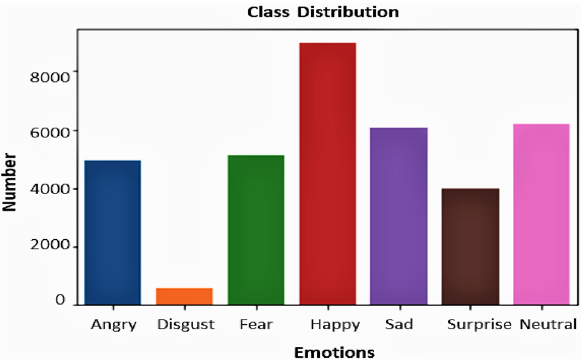
Figure 9. Seven facial expressions distribution of the FER2013